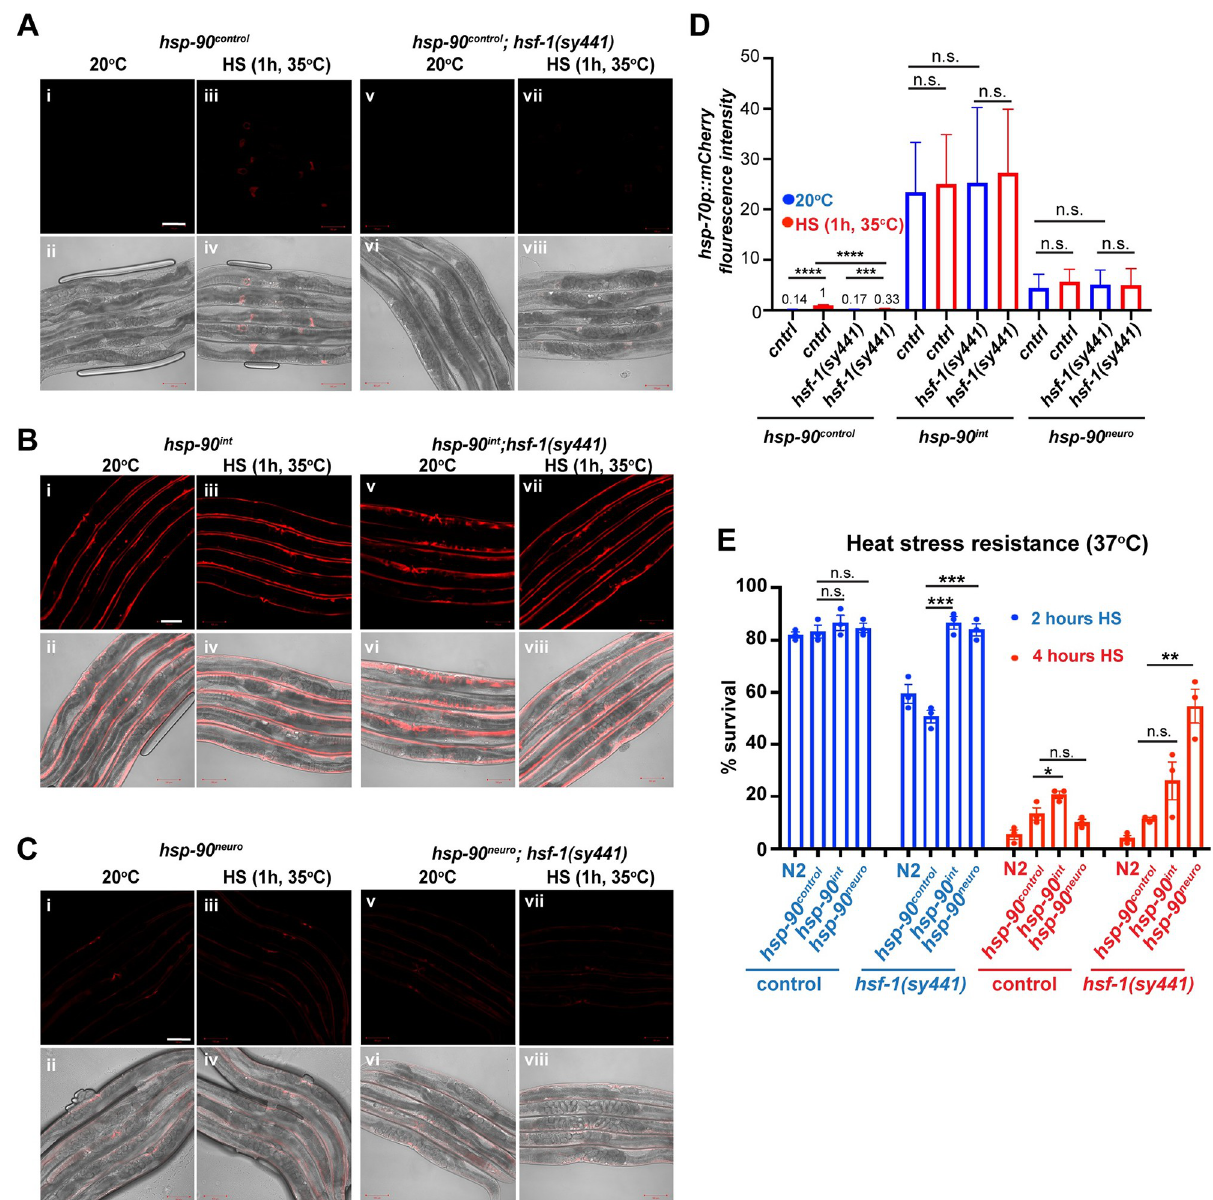
Fig 2. TCS-induced hsp-70 expression is regulated independently of hsf-1 . ( A ) The hsp-70p :: mCherry reporter is not expressed in hsp-90 control (i, ii) and hsp-90 control ;hsf-1(sy441) (v, vi) at 20˚C. hsp-70p :: mCherry is induced in hsp-90 control after a 1-h HS at 35˚C (iii, iv) , but not in hsp-90 control ;hsf-1 (sy441) mutants (vii, viii) . ( B ) Tissue-specific knockdown of hsp-90 in the intestine ( hsp-90 int ) induces the hsp-70p :: mCherry reporter in the muscle at 20˚C (i, ii) and after HS at 35˚C (iii, iv) to a comparable level. hsp-70p :: mCherry expression in hsp-90 int animals before or during HS (1-h at 35˚C) is independent of hsf-1 ( v–viii ). ( C ) Expression of the hsp-70p :: mCherry reporter in hsp-90 neuro (i, ii; v, vi) and hsp-90 int ; hsf-1(sy441) animals (iii, iv; vii, viii) before and after HS. ( D ) Quantification of hsp-70p :: mCherry fluorescence intensity at 20˚C or after HS (35˚C) in control ( hsp-90 control ) or hsp-90 int and hsp-90 neu animals harboring wild-type or mutated hsf-1 . ( E ) Survival of hsp-90 int ;hsf-1(sy441) and hsp-90 neu ; hsf-1(sy441) animals compared to hsp- 90 control after a 2- and 4-h HS at 37˚C. N2 nematodes were used as an additional control. ( D, E ) Bar graphs represent the average of 3 biological replicates of 50 animals per condition. Error bars represent SEM of the 3 biological replicates. Significance compared to hsp-90 control was determined using Student’s t test. � P < 0.05; �� P < 0.01; ��� P < 0.001; ���� P < 0.0001; n.s. = not significant. Source data for Fig 2D and 2E is provided in S2 Data. HSF-1, heat shock factor 1; TCS, transcellular chaperone signaling.